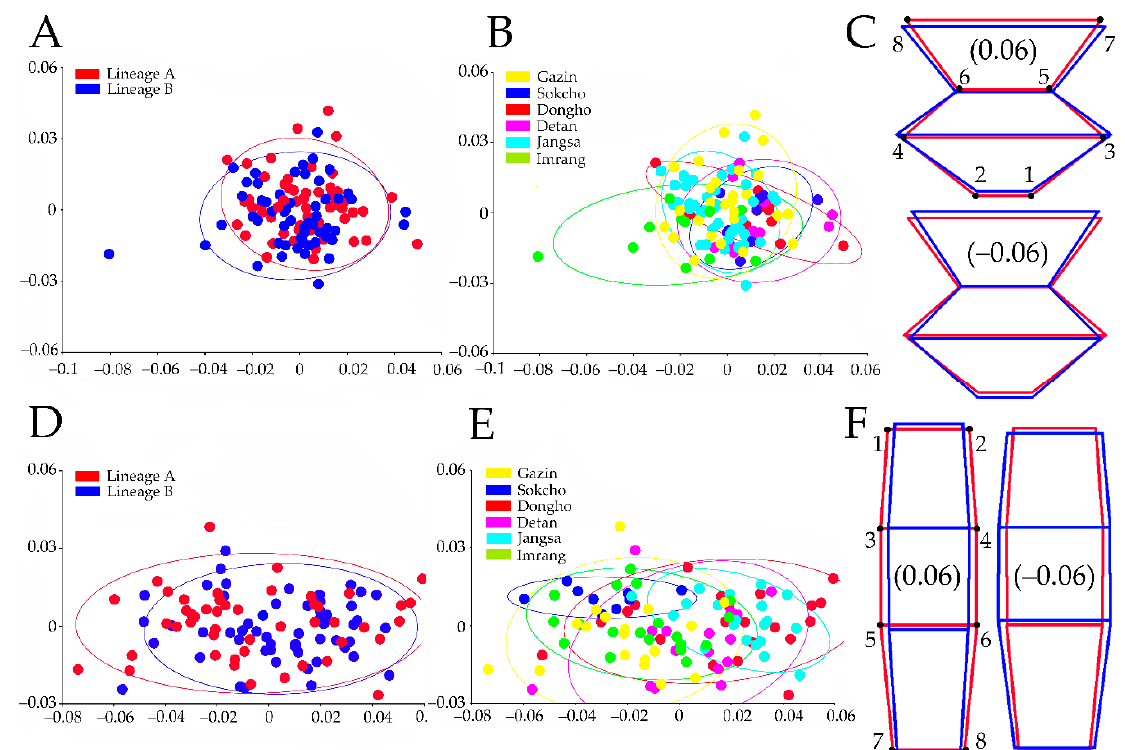
Figure 4. Principal component analysis on the residuals of sensilla distribution (SD) and pleonal points (PP) shape coordinates and wire frame images. ( A ) Scatter plot classified by lineage on the female SD dataset, both axes indicate principal component I and II, respectively; ( B ) scatter plot classified by population on the female SD dataset; ( C ) SD shape change (blue line) against mean shape (red line) according to the corresponded shape scores, the digitized landmarks are indicated by the numbers; ( D ) scatter plot classified by lineage on the female PP; ( E ) scatter plot classified by population on the female PP; ( F ) PP shape change (blue line) against mean shape (red line) according to the corresponding shape scores.